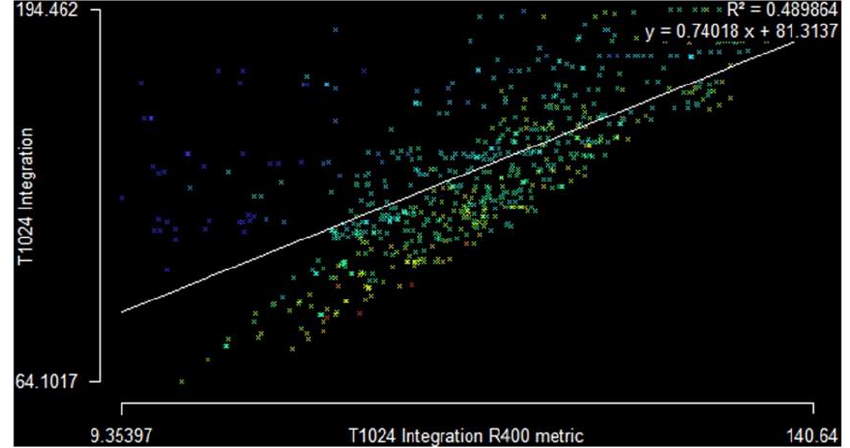
Figure 4. The space syntax model analysis result on Nanxun: Intelligibility value.